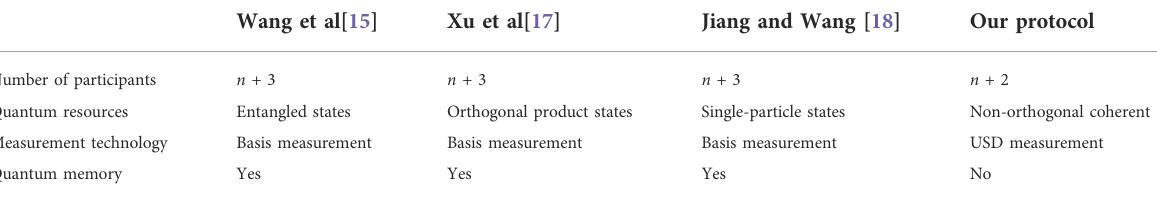
TABLE 1 Comparison with other quantum voting